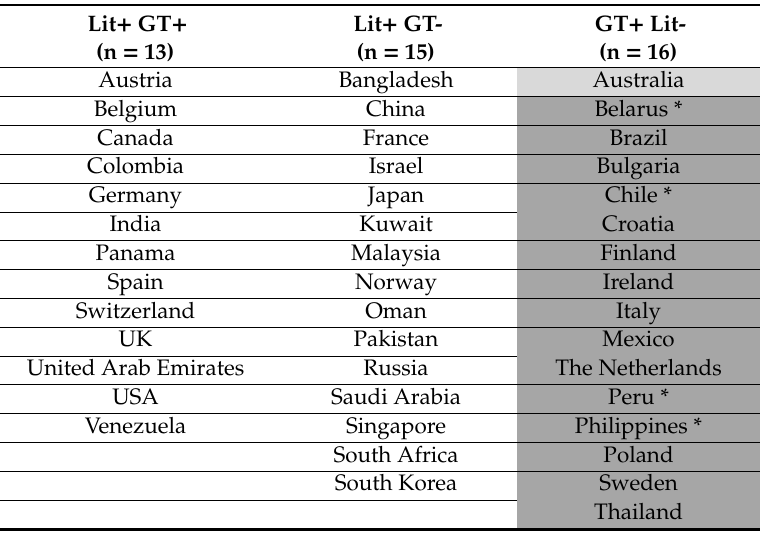
Table 1. Overview of C. auris in published literature, Google Trends and key opinion leaders (KOL) from 2016 to the middle of